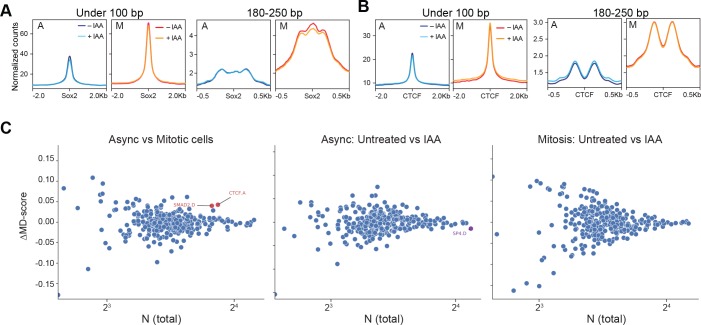
ATAC-seq at enhancer and CTCF sites.(A) After combining all replicates, average signal around Sox2 sites were plotted for reads under 100 bp and 180–250 bp. (B) Same as in A, but for CTCF sites. (C) MA-plots. For all transcription factor motif models in mm10 (each dot), the change in MD-score in Async vs Mitosis (left), untreated vs IAA in Async cells (middle), and untreated vs IAA in Mitotic cells (right), are plotted relative to the number of motifs within 1.5 kb of any ATAC-seq peak center (x-axis). MD-scores are defined as the enrichment of a TF sequence motif within a small radios (150 bp) of ATAC-seq peaks relative to a larger local window (1500 bp) (Tripodi et al., 2018). Significantly different MD-scores are highlighted in red and purple (p-value<1×10−6). These analyses show that the majority of TF motifs show no change in enrichment in each condition tested. In Asynchronous vs Mitotic cells, only two factors show higher enrichment in Asynchronous vs Mitosis: CTCF and SMAD2.D. In Asynchronous cells, only SP4.D shows higher enrichment in TBP degraded vs untreated cells.